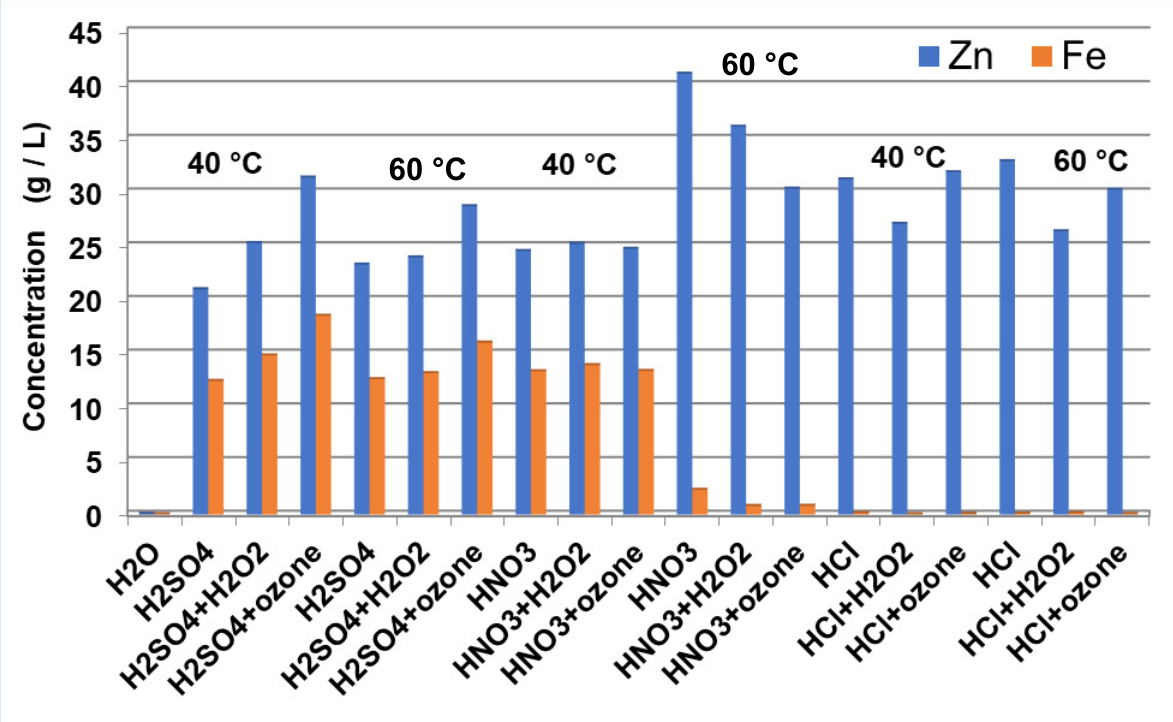
Figure 4. Effectiveness of leaching of Zn and Fe (sludge) D20 depending on the type of leaching agent, additives and temperature (g/L).